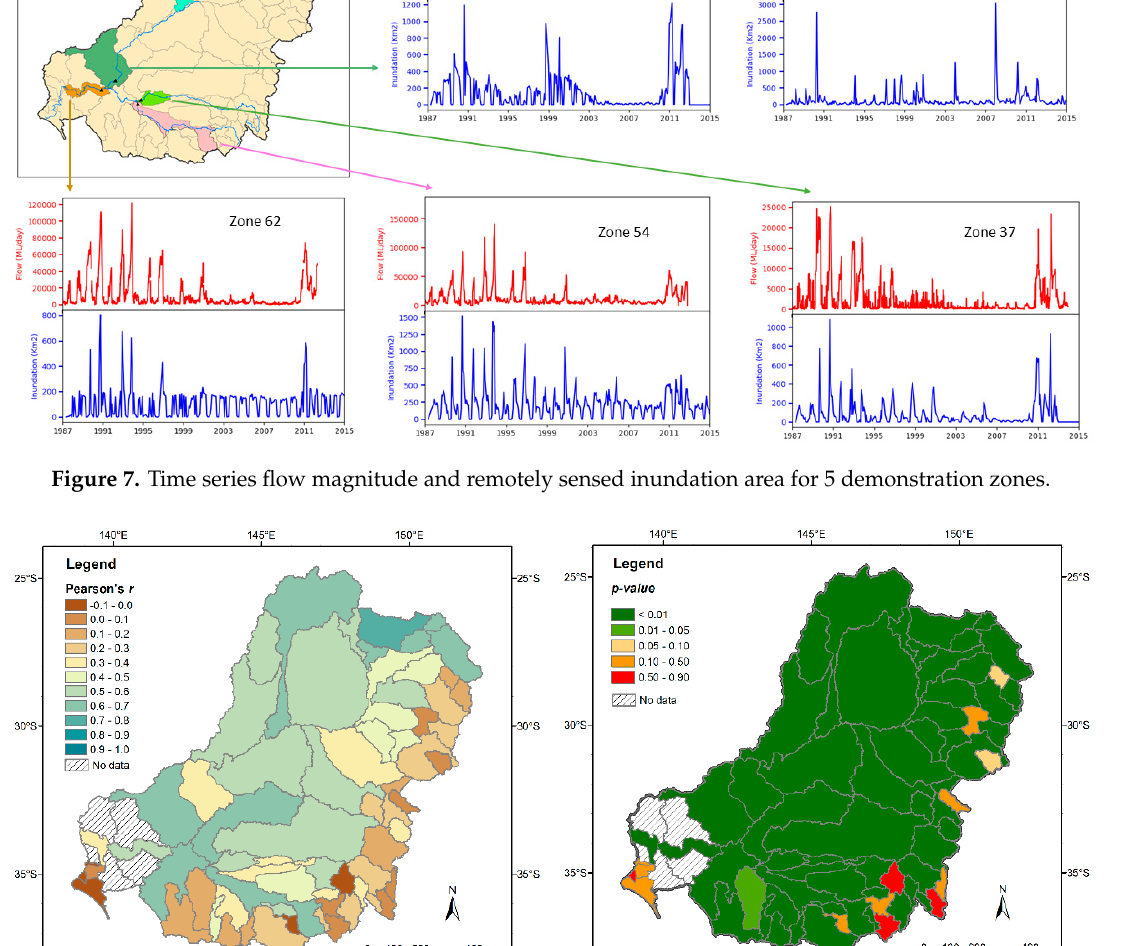
Figure 7. Time series flow magnitude and remotely sensed inundation area for 5 demonstration zones.